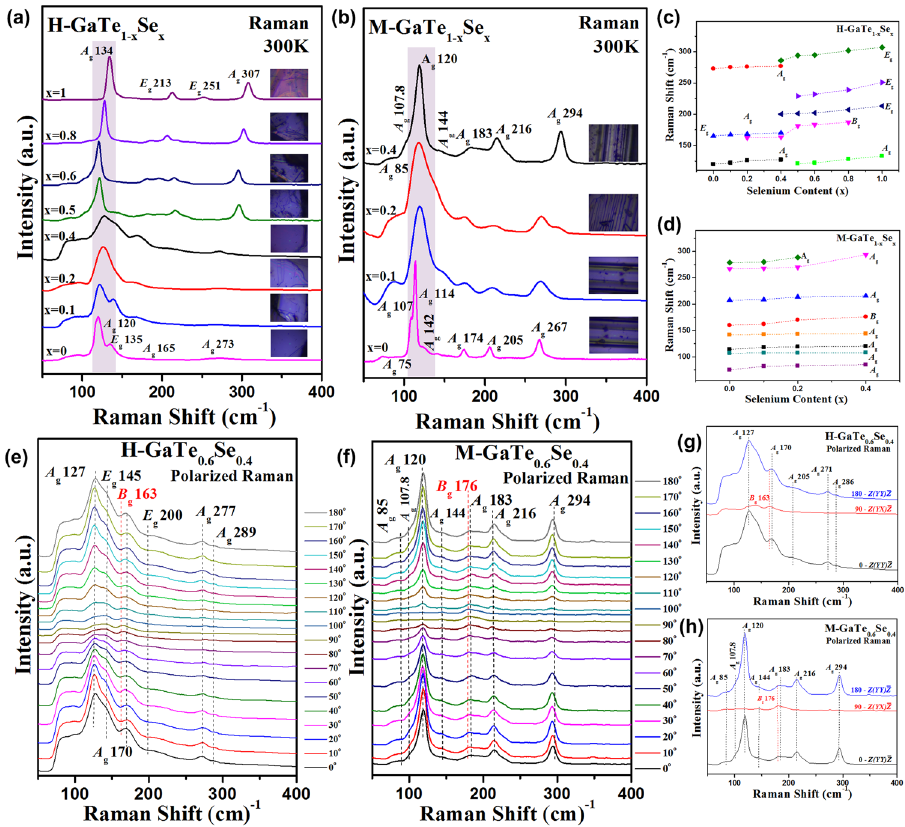
Fig. 5 Polarized Raman result of M- and H-GaTe 1 − x Se x . μ Raman spectra and microscope images of ( a ) multilayered H-GaTe 1 − x Se x (0 ≤ x ≤ 1) and ( b ) multilayered M-GaTe 1 − x Se x (0 ≤ x ≤ 0.4) at 300 K. c Frequencies of the Raman modes of H-GaTe 1 − x Se x (0 ≤ x ≤ 1) versus selenium content. d Raman frequencies of multilayered M-GaTe 1 − x Se x (0 ≤ x ≤ 0.4) versus selenium content. e Angular-dependent polarized Raman spectra of a selected sample of H-GaTe 0.6 Se 0.4 from θ = 0° to 180°. f Angular-dependent polarized Raman spectra of the selected sample of M-GaTe 0.6 Se 0.4 from θ = 0° to 180°. A comparison of the in-plane structural anisotropy of ( g ) H-GaTe 0.6 Se 0.4 and ( h ) M-GaTe 0.6 Se 0.4 using polarized Raman measurements at θ = 0°, θ = 90°, and θ = using angular-dependent polarized μ Raman measurement. Figure 5a, b shows the unpolarized μ Raman spectra of multilayered H-GaTe 1 − x Se x (0 ≤ x ≤ 1) and M-GaTe 1 − x Se x (0 ≤ x ≤ 0.4). A micro- scope image of each sample is also displayed in the inset of each spectrum showing a plate shape for H phase and a line-edge shape for M phase. The detection limit of the M phase was up to x = 0.4 in Fig. 5b), similar to that of μ PL and μ TR. The Raman modes observed in multilayered H-GaTe 1 − x Se x (0 ≤ x ≤ 1) and M-GaTe 1 − x Se x (0 ≤ x ≤ 0.4) are, respectively, depicted in Fig. 5c, d, and the peak values of the modes are listed in Supplementary Table 12 for H-GaTe 1 − x Se x (0 ≤ x ≤ 1) and Supplementary Table 13 for M-GaTe 1 − x Se x (0 ≤ x ≤ 0.4). The assignments of the A g (out-of-plane) and E g (in-plane) related modes were based on previous Raman results obtained for GaTe 29 and GaSe 56 . For both series of H-GaTe 1 − x Se x (0 ≤ x ≤ 1) and M-GaTe 1 − x Se x (0 ≤ x ≤ 0.4), the peak energies (wavenumbers) of the Raman modes increased as the Se content increased, owing to the smaller atomic weight of Se compared to tellurium in the crystal lattice of the layers. For x ≥ 0.5, the main Raman peak of the A g mode in the H-GaTe 1 − x Se x (0 ≤ x ≤ 1) series in Fig. 5a shows blue-shift behavior from A g = 121 cm − 1 ( x = 0.5) increasing to A g = 134 cm − 1 ( x = 1), suggesting hexagonal-phase planes; how- ever, for x < 0.5 (i.e., x ≤ 0.4), the Raman peak feature is much broader and has shifted from 127 cm − 1 ( x = 0.4), 126 cm − 1 ( x = 0.2), and 122 cm − 1 ( x = 0.1) down to 120 cm − 1 ( x = 0) in